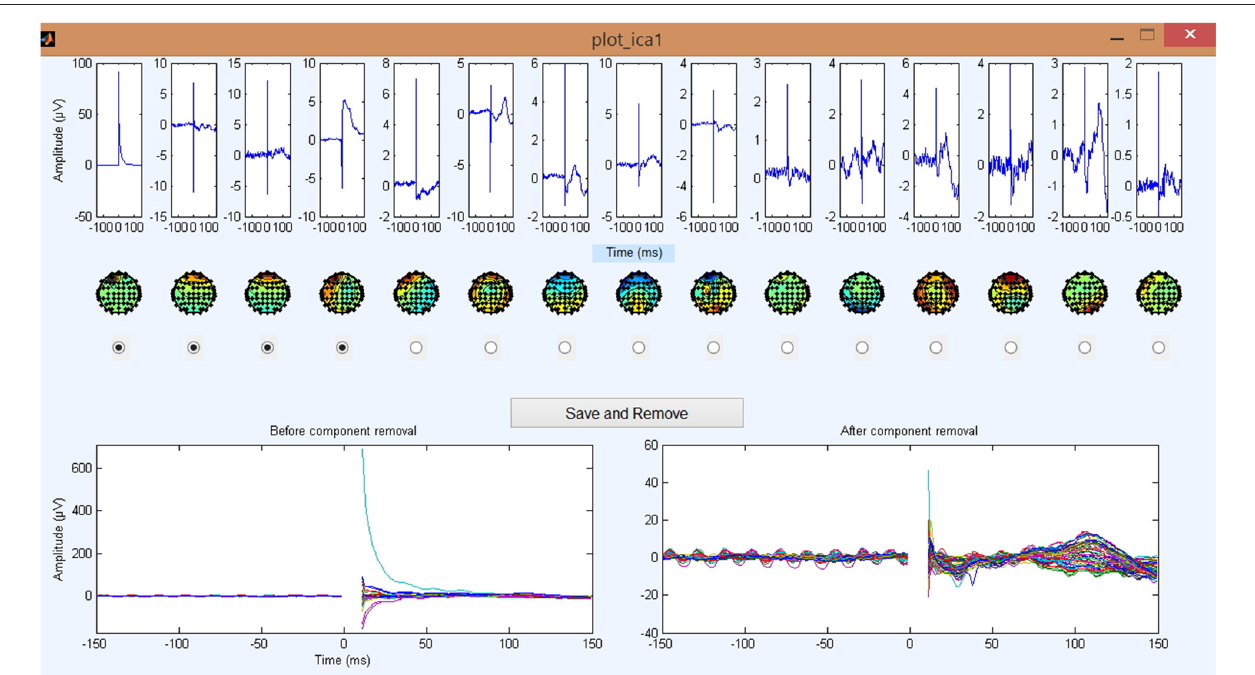
FIGURE 6 | Step 5 GUI for removing the TMS decay artifact. The plots in the top row are the 15 largest independent component analysis (ICA) components averaged across trials and sorted by component variance. Corresponding scalp plots are shown below. The bottom left butterfly plot displays the EEG data averaged over all trials before the removal of any ICA components (each colored line presents a channel). The bottom right butterfly plot shows the updated EEG data averaged over all trials after the deletion of tagged ICA components. Note the drastic change in the amplitude of the y -axis from the left panel (1000 µ V) to the right panel (100 µ V) and the unmasking of smaller evoked signals. For all waveform plots, x -axis represents time in milliseconds relative to presentation of TMS pulse and y -axis represents the amplitude of the EEG signal in µ V.